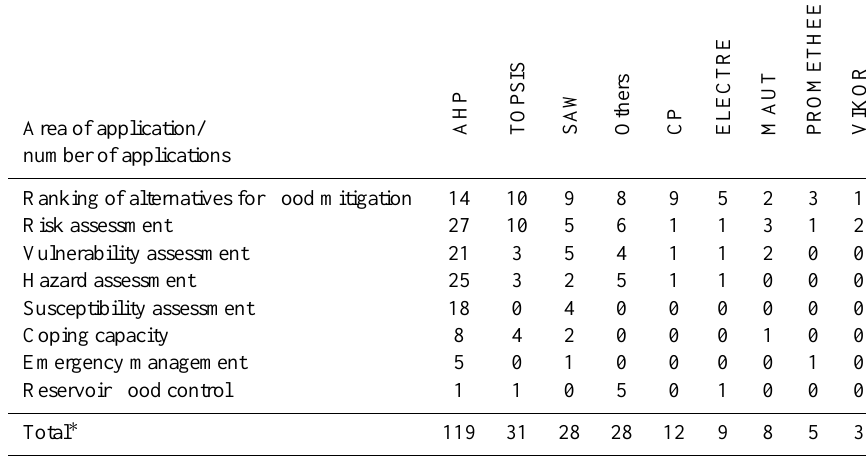
Table 5. Distribution of applications by MCDM method and area of